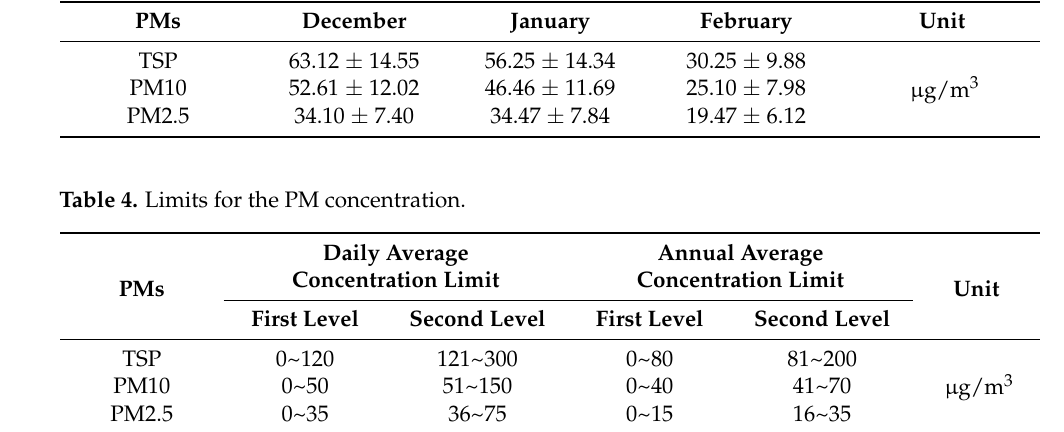
Table 3. Descriptive statistics of PM concentration (Mean ± SD).